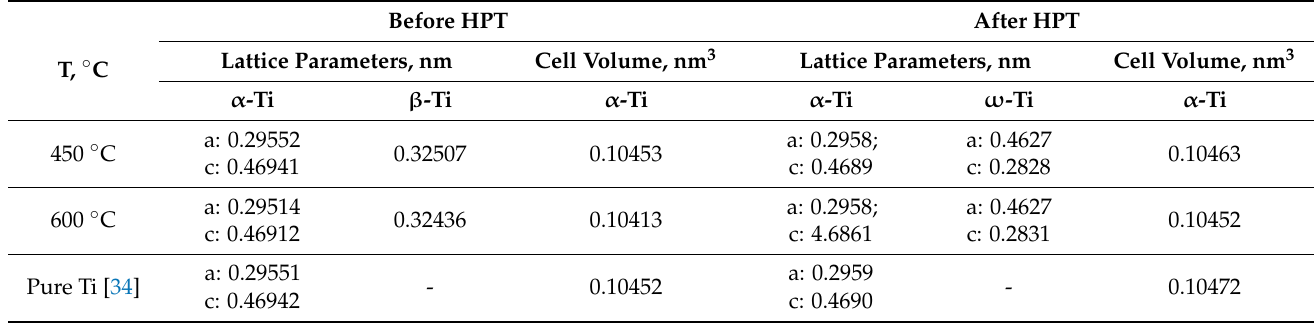
Table 1. Lattice parameters of all phases and the cell volume of the α -phase before and after HPT.